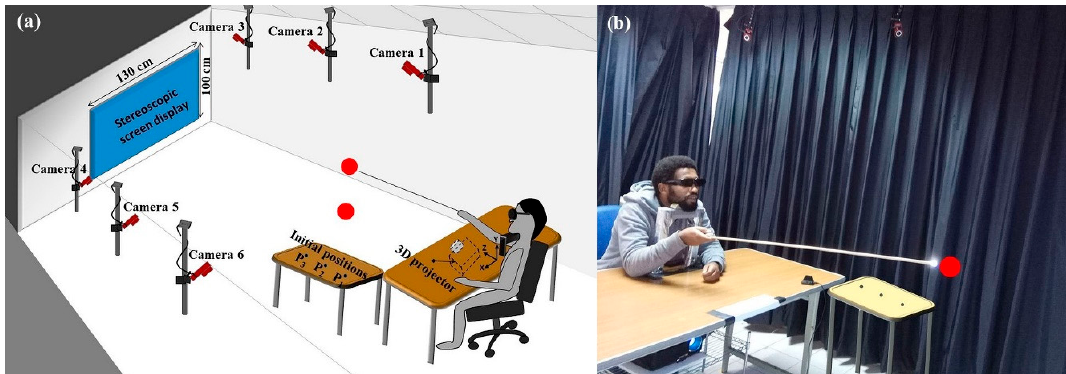
Figure 3. Illustration of ( a ) the experimental setup and ( b ) a participant during the experiment in the direct interaction condition. A chinrest was used to keep the participant’s head fixed, and the 3D projector was placed under the right-hand table. The origin for reference of measurement was in line with the center of the projector and at table height (75 cm above the floor).